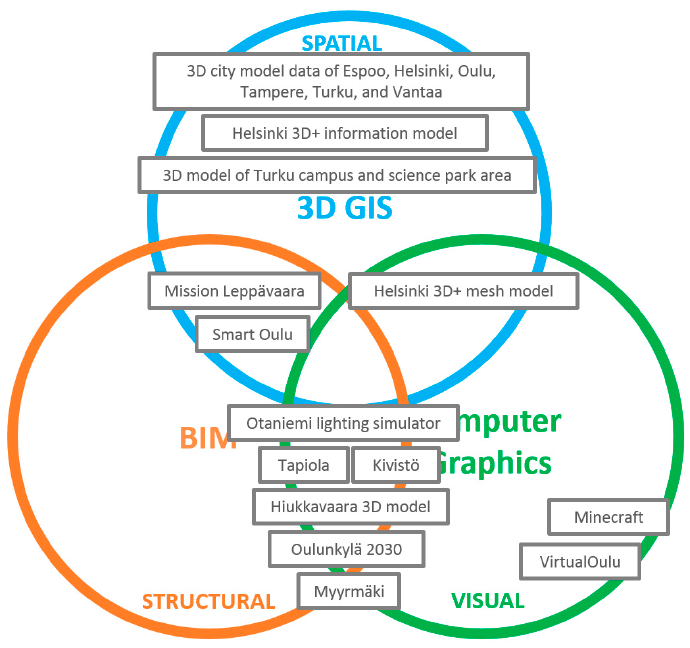
Figure 5. The studied 3D modeling activities in three categories representing distinct operational cultures.